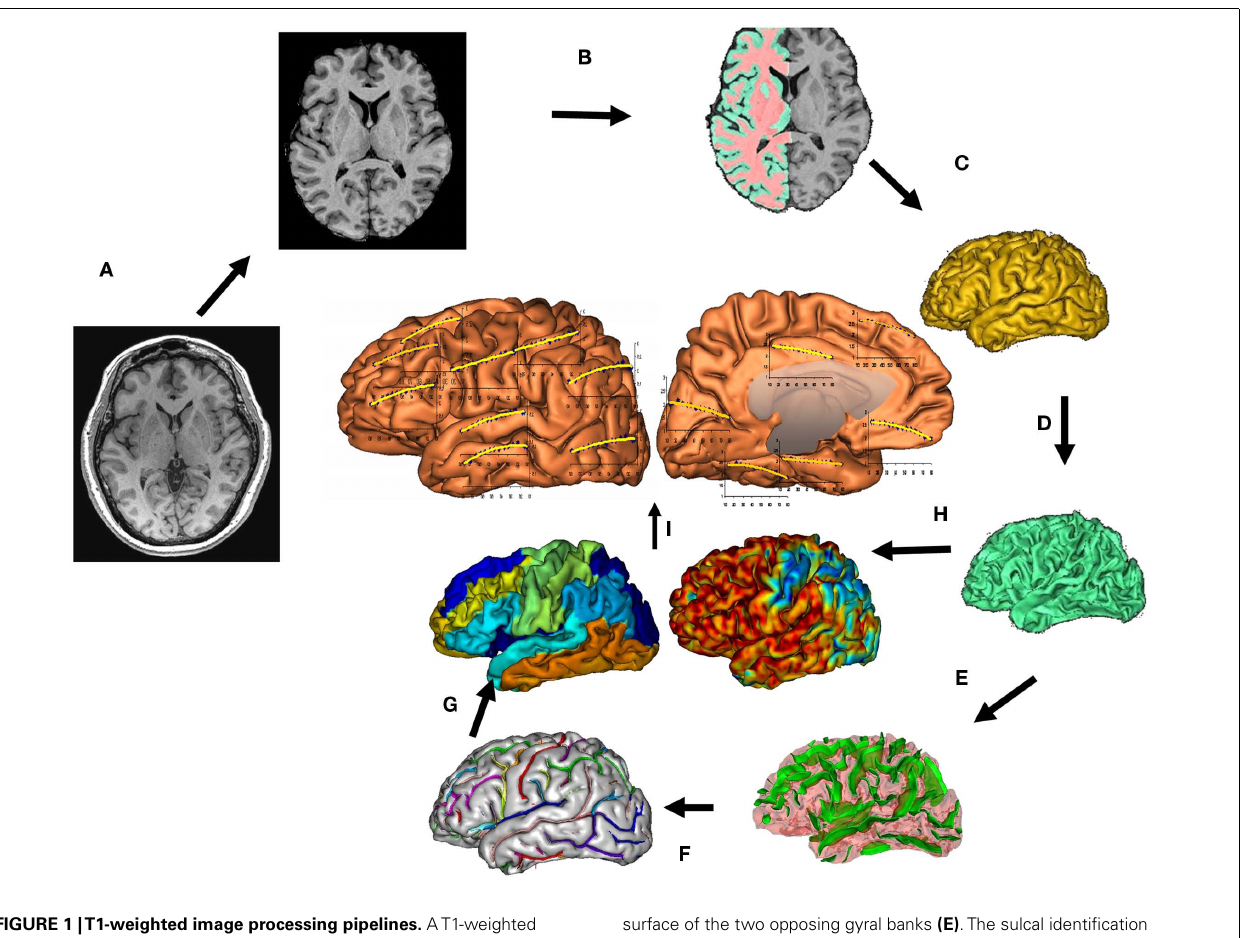
FIGURE 1 |T1-weighted image processing pipelines. AT1-weighted image is skull-stripped, globally spatially normalized, and RF-inhomogeneity corrected (A) . Next, cerebral hemispheres and cerebellum and identified and tissue classified (B) . Cortical surfaces for GM andWM are calculated (C,D) and a homotopic erosion operation and crevasse detector are used to reconstruct sulcal surface as the medial